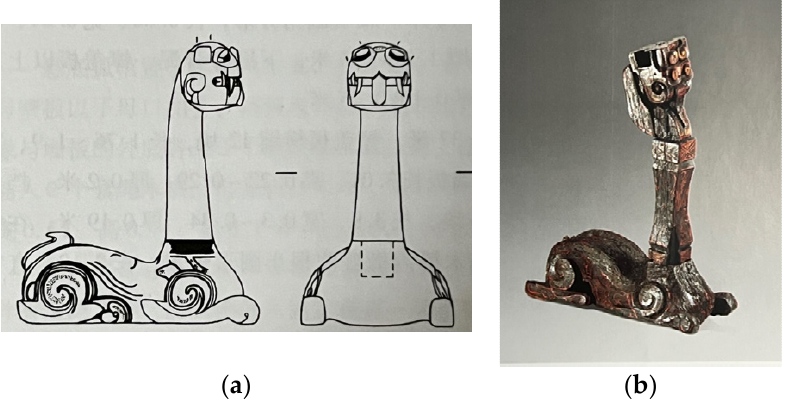
Figure 8. ( a ) Line drawing of lacquered wood antlered and tongued sculpture from Tomb 143 at Yugang, Xiangyang County, Hubei . From Xiangyang shi wenwu kaogu yanjiusuo (2011a, 219 fig. 195.16). ( b ) Lacquered wood antlered and tongued sculpture from Tomb 145 at Yugang, Xiangyang County, Hubei. From Xiangyang shi wenwu kaogu yanjiusuo (2011b, color plate 46.1). Both sculptures were originally equipped with deer antlers.